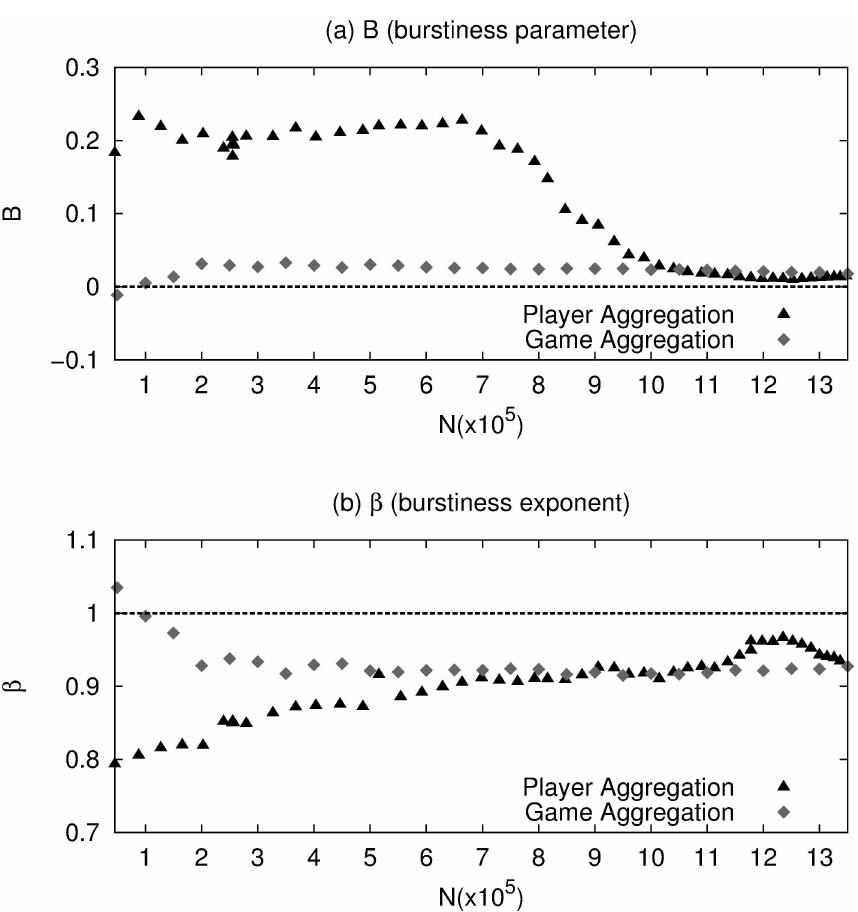
Fig 7. (a) Burstiness parameter B and (b) burstiness exponent β as a function of the length of the time series for the database growing by Player Aggregation (black triangles) and by chronological game aggregation (gray diamonds). The error bars are not shown becausethey are of the same size as the